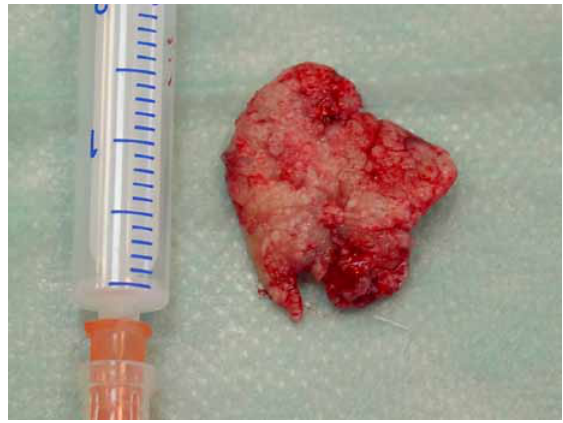
Figure 2. Tumour 2.5x2.0 cm after a total excision.